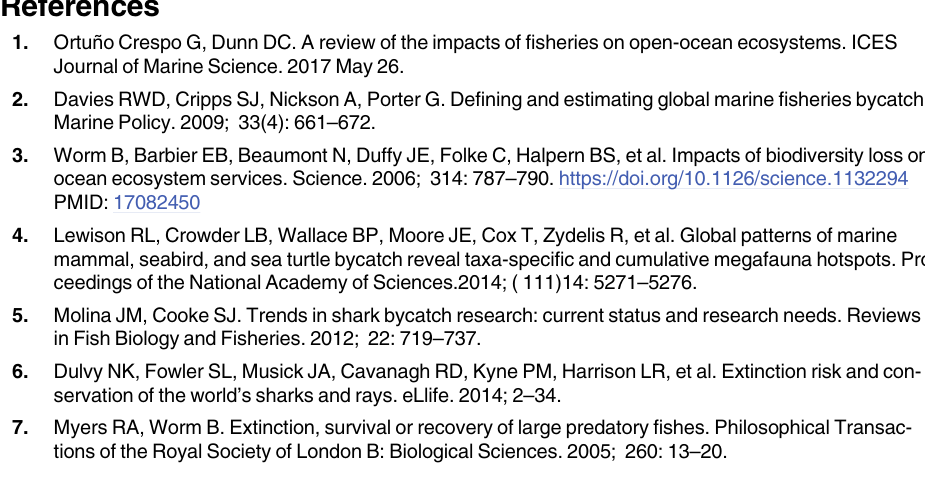
S1 Fig. Differences in mean levels of estimated CPUE of M . mustelus (on the left) and S . acanthias (on the right) among fishing regions (1–5) during mating period and other peri- ods. On the Y axis, each fishing regions (1–5) is represented on the left of the x, while the reproductive period effect is the number on the right and it has two levels (1 = mating period, 0 = other period). Significant differences in mean level of catch rate are highlighted in red. S2 Fig. Differences in mean levels of CPUE of M . mustelus (on the left) and S . acanthias (on the right) within potential nursery areas and fishing area